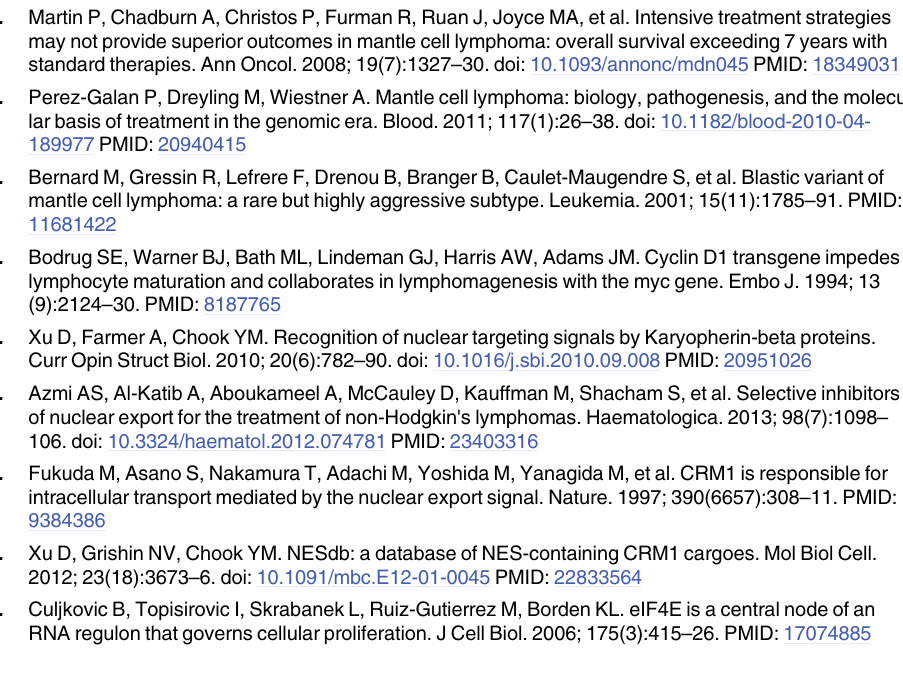
S1 File. Lists of consistently down- (Table A in S1 File) or up-regulated (Table B in S1 File) genes by KPT-185.treatment in JVM-2 cells transfected with control shRNA or p53-specific shRNA. Mean fold-change was determined from the average of gene expression changes of each of 3 independent experiments in JVM2 transfected with control shRNA (shC JVM2)